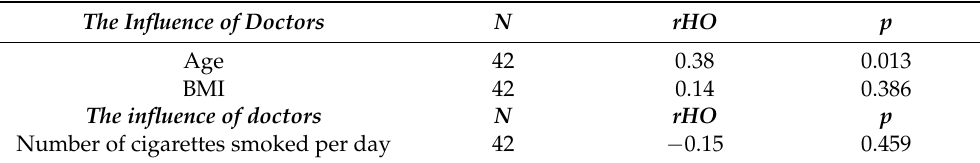
Table 6. Influence of doctors vs. age, BMI, and nicotine